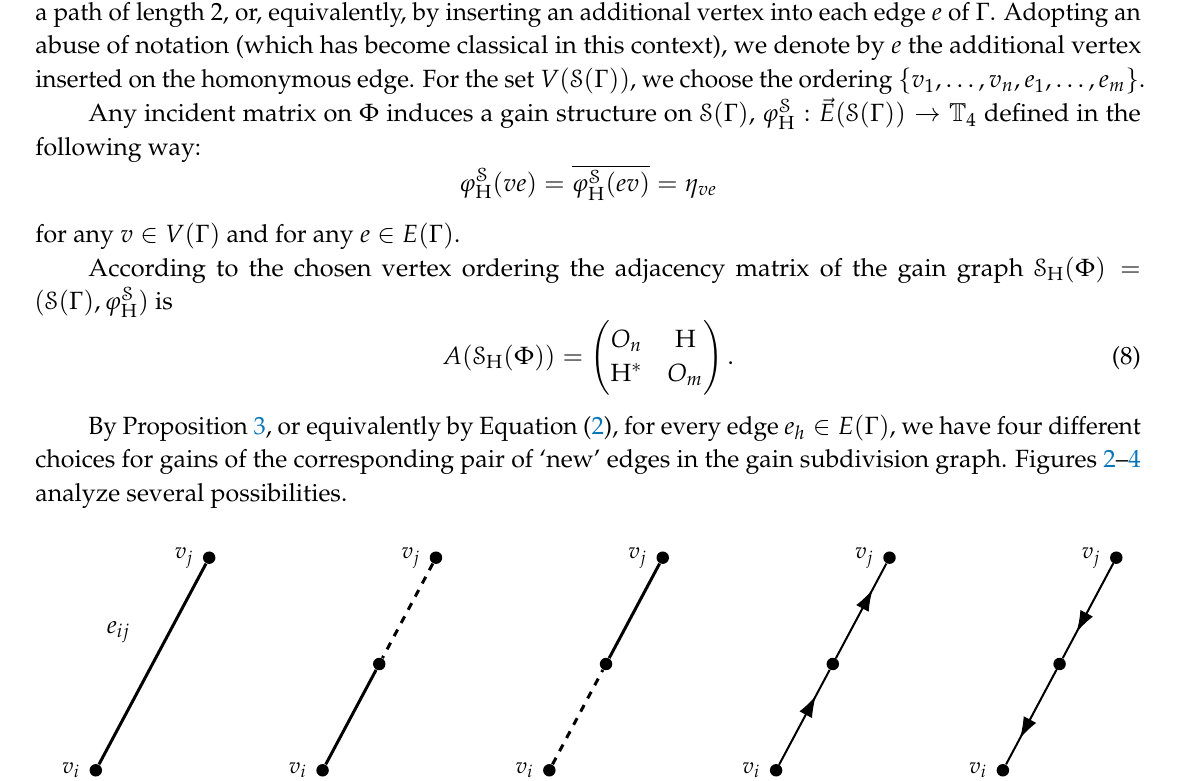
Figure 2. Four possibilities for gains on the pair of edges in the subdivision graph corresponding to e ij ∈ (cid:126) E ( Φ ) when ϕ ( e ij ) = 1.